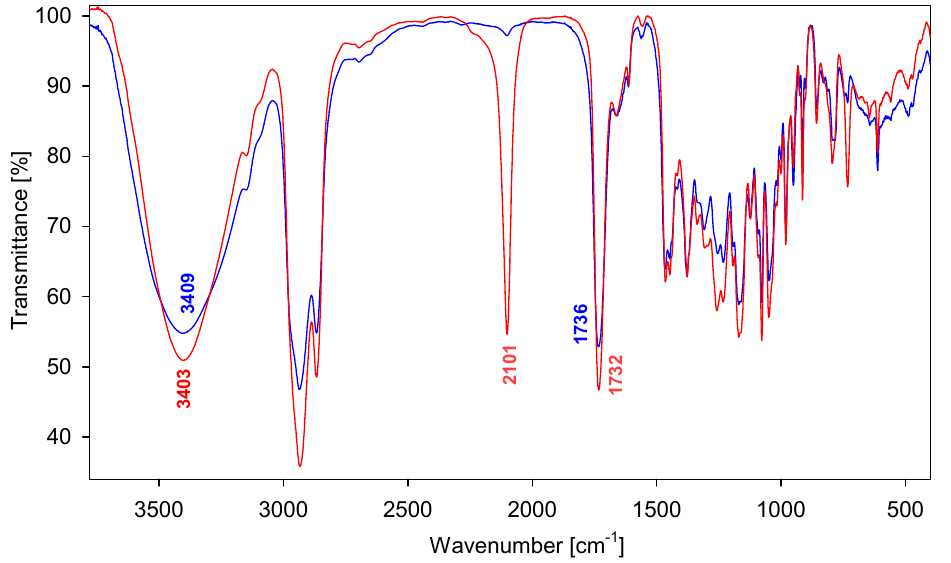
Figure 2. FT-IR spectra of 10 (red) and 13 (blue) in the 3,700–400 cm − 1 region.